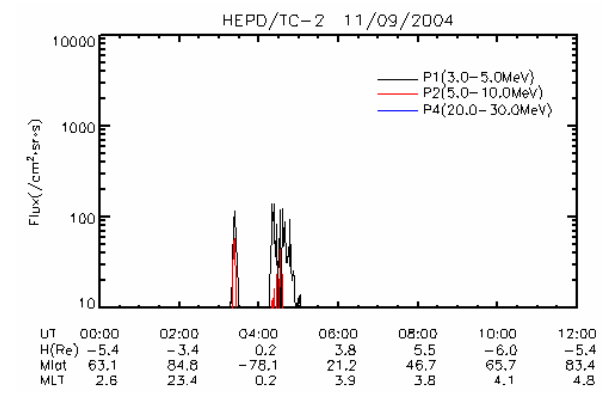
Fig. 12. The minute-averaged high energy electron fluxes recorded in energy channels E0, E3 and E6 on 12 August 2004.